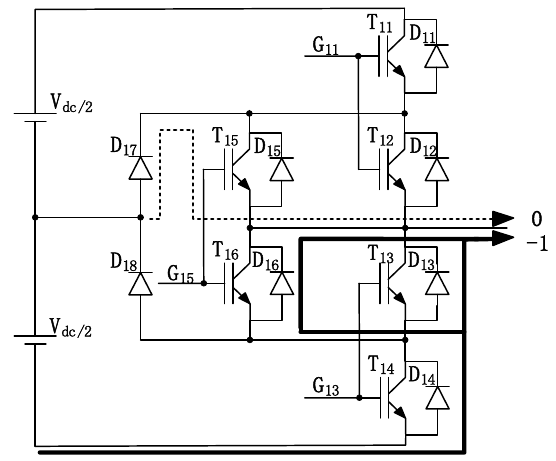
Figure 8. ID2 type ( α = − 1, M = 1.15).